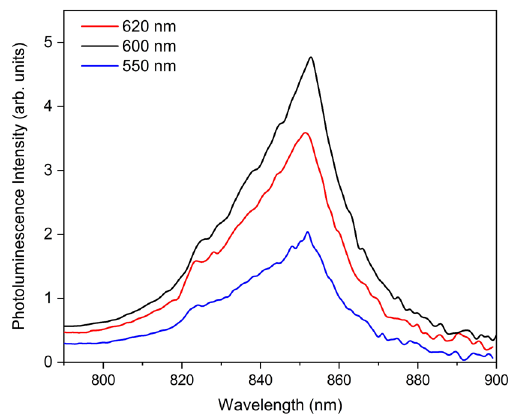
=692 nm and (b) em